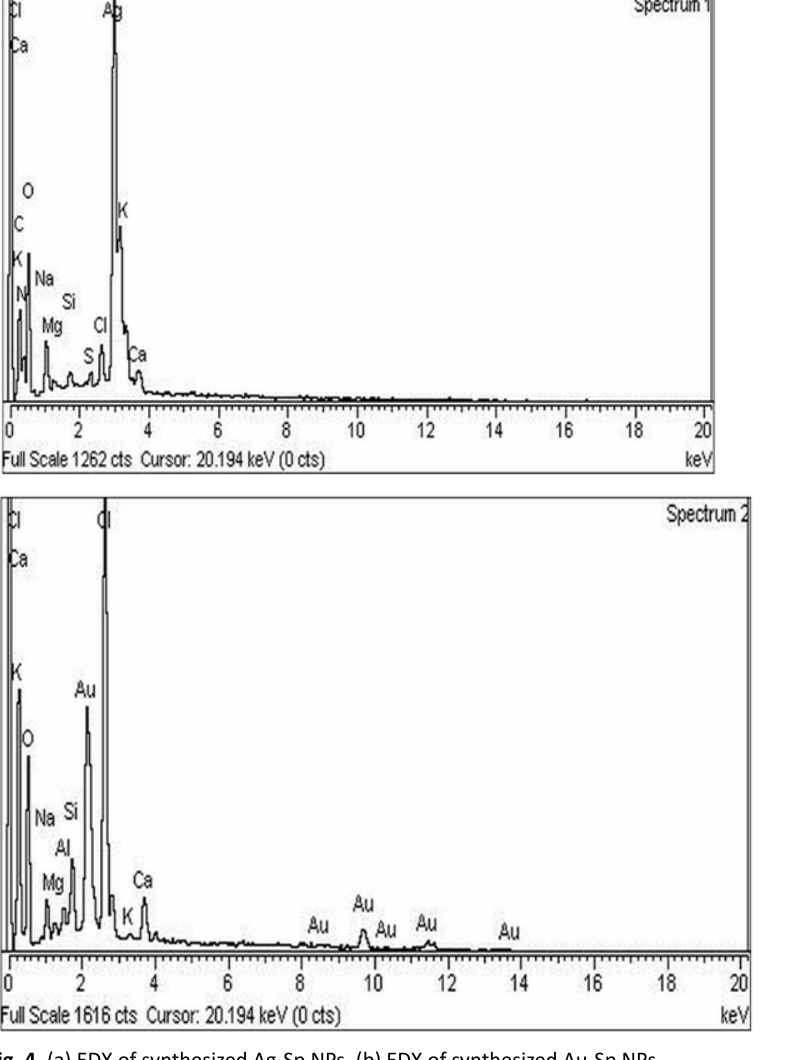
one way analysis of variance (ANOVA). The analysis was done by using Graphpad Prism